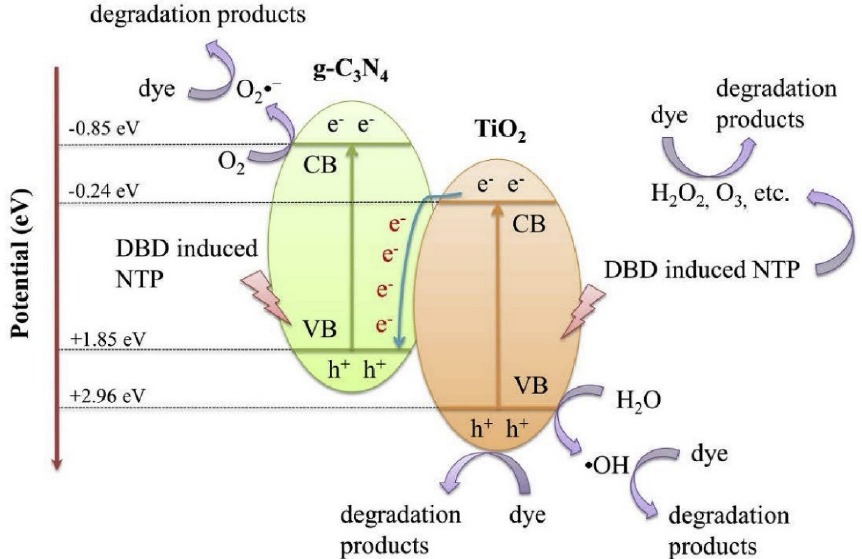
Figure 13. Proposed synthetic catalytic mechanism for dye degradation in the NTP + g−C 3 N 4 /TiO 2 system. Reprinted with permission from Ref. [239]. Copyright 2020, Elsevier.